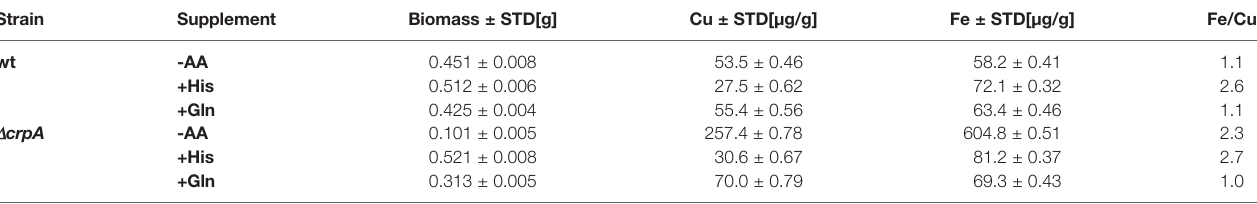
A.fumigatuswtand D crpAstrainsweregrowninliquidAMMcontaining0.005mMCuand20mMammoniumasnitrogensourcewithoutAAs(-AA)orsupplementedeitherwith5mMGln (+Gln)or1mMHis(+His). Aftercultivation,drybiomassandcellularcontentsinCuandFewere determinedafterfreeze-dryingoftheharvestedmycelia.Theshownvaluesarethemean± standard deviation (STD) of three biological